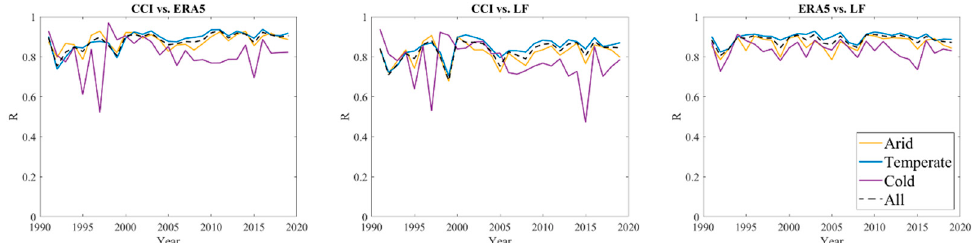
Figure 3. Correlation of LF and ERA5 with climate change initiative (CCI) during the coinciding periods (1991–2019) and by climate zones of the Iberian Peninsula.